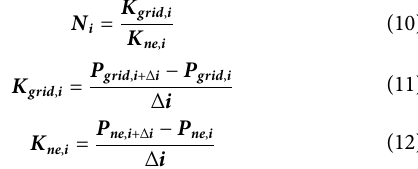
FIGURE 6 Flowchart of K-means